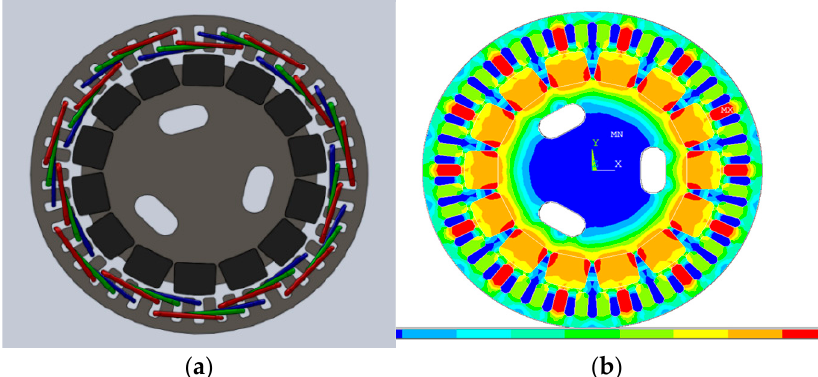
Figure 4. ( a ) CAD model of the demonstration machine. ( b ) FEA solution–flux density plot for the zero rotor angle. Table 1. Physical parameters of the three-phase permanent magnet generator demonstration.